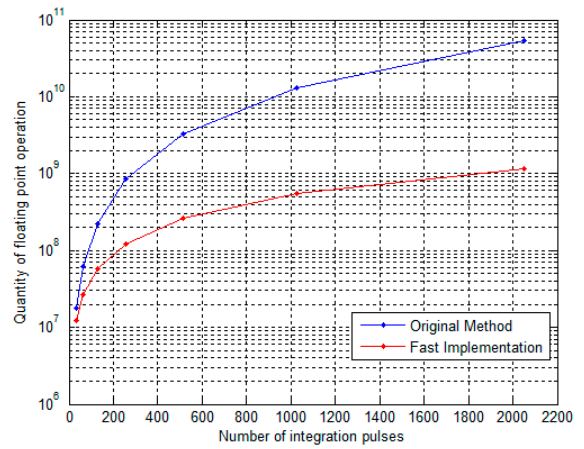
Figure 3. The comparison of computing load for different pulse numbers.